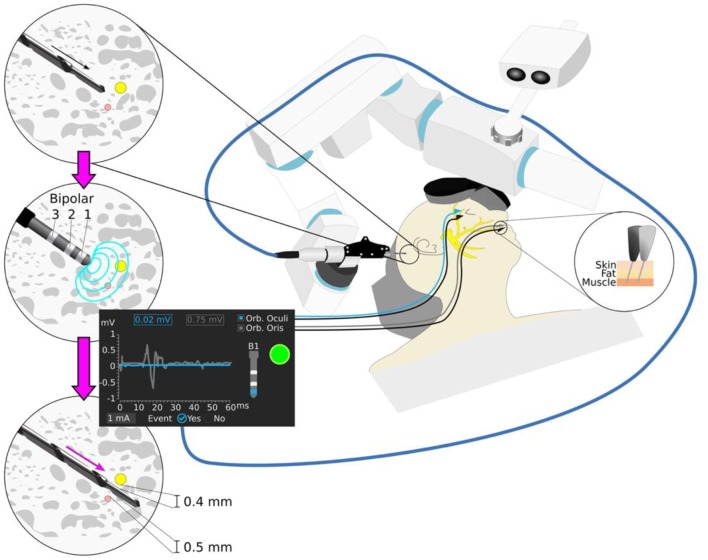
Robotic cochlear implantation supported by facial nerve monitoring. Robotic drilling is performed from the surface of the mastoid to a first safety point 3 mm before the facial nerve (yellow) and the chorda tympani nerve (pink). The robot drill is retracted and the stimulating probe with monopolar and bipolar configurations (Bipolar 1,2,3) is inserted to the end of the trajectory, following application of a stimulation intensity ramp (0.2–2 mA, 4 Hz, 250 μs). The minimum intensity that elicits a muscle evoked potential above threshold is registered for each configuration. Different stimulus thresholds are expected to provide different prediction of distance to the facial nerve. A stimulation intensity above 0.35 mA (bipolar configuration) suggest sufficient facial nerve distance to ensure structural preservation of the facial nerve (e.g., 1 mA stimulus threshold bipolar B1).